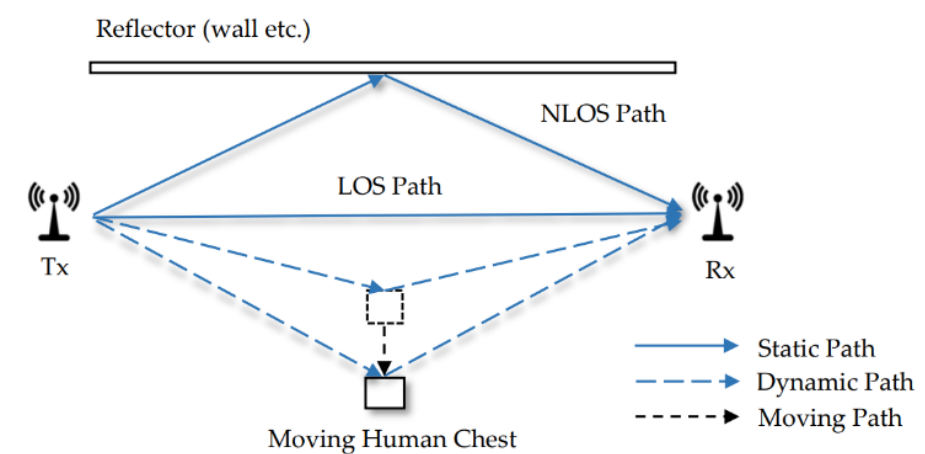
Figure 2. Indoor multipath environment with human movement.